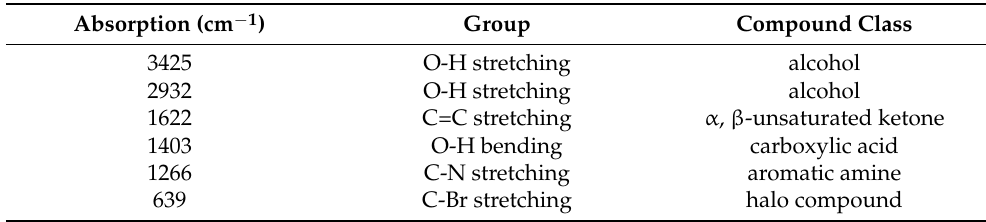
Table 4. FTIR analysis of the water extract of T. aphylla.